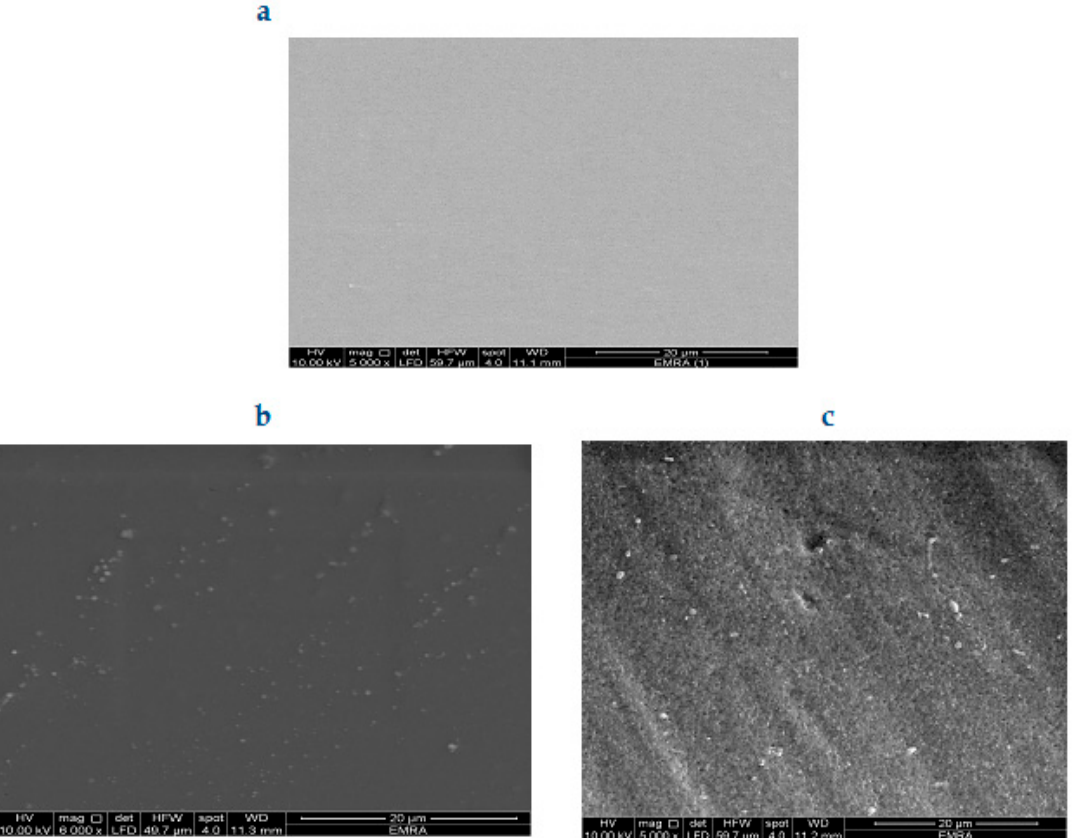
Figure 3. SEM images of the casted cellulose acetate film: ( a ) pure fabric, ( b ) fabric loaded with RBH by pre-treatment, and ( c ) fabric loaded with RBH by post-treatment.